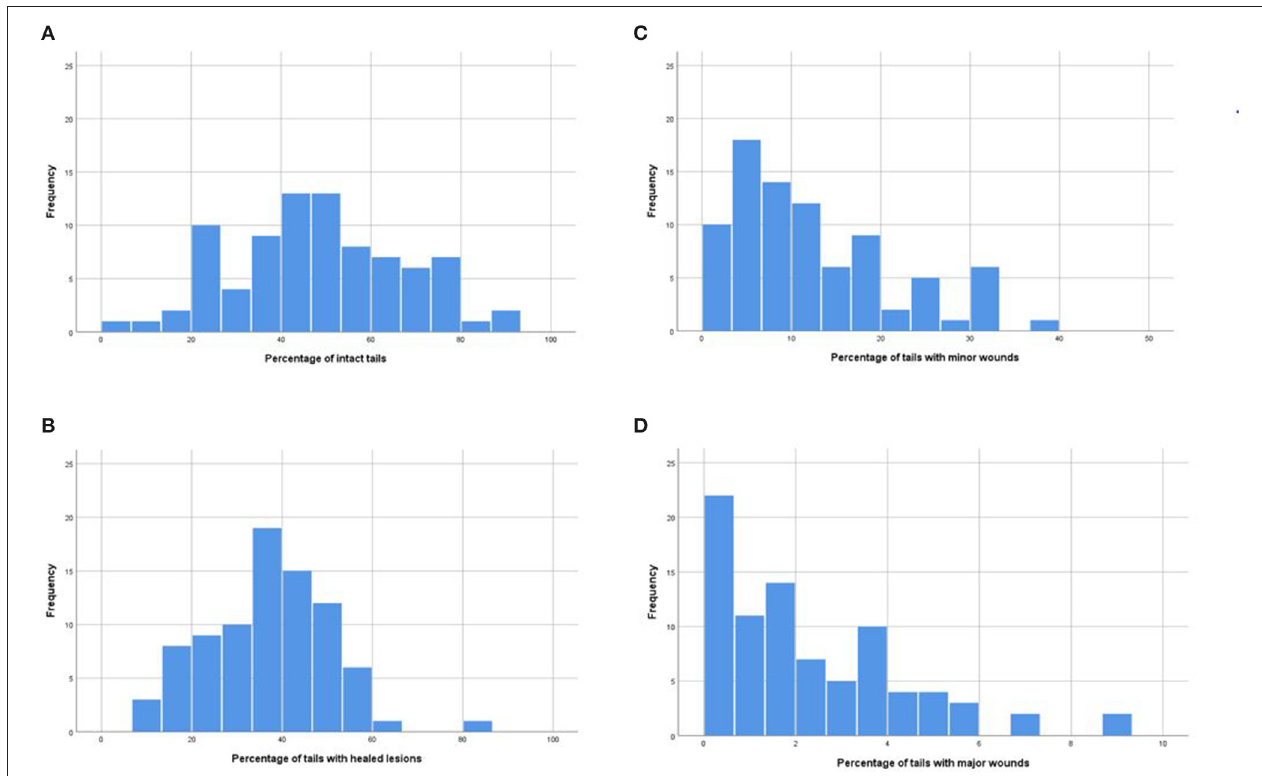
FIGURE 1 | Frequency distributions of percentages of tail classifications in 84 herds: (A) intact tails, (B) healed tails, (C) tails with minor wounds, (D) tails with major wounds. Undocked tails of finishing pigs ( n = 10,517) were evaluated at the slaughterhouse after scalding.